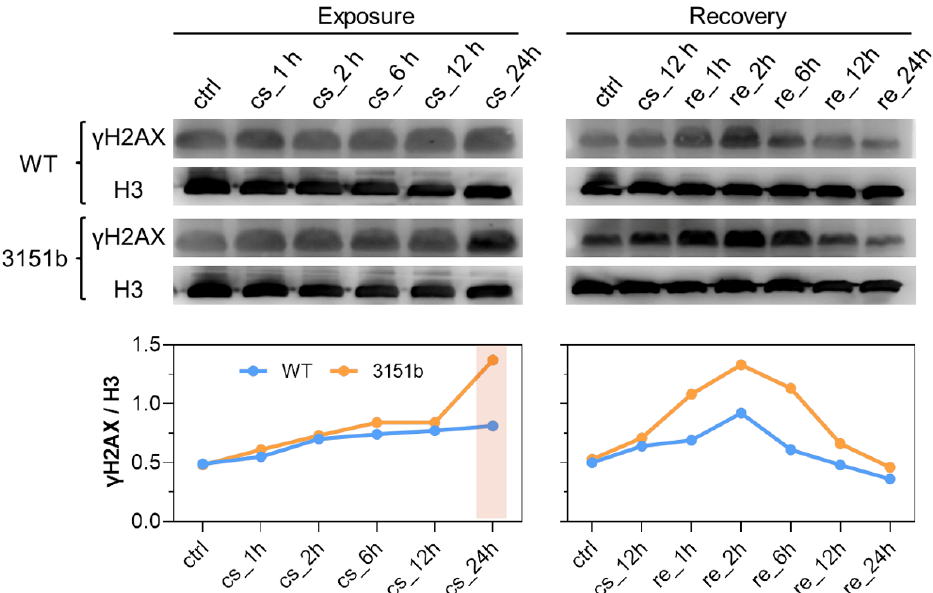
Figure 6. Tmem39b protects the organism from cold-warm stress-induced DNA damage. The upper panel contains Western blots for the WT and tmem39b mutant samples collected at the indicated time points. The membranes were immunostained with antibodies against γ H2AX and histone H3. The line charts illustrate the γ H2AX/H3 ratio of optical density obtained by analyzing the corresponding protein bands.